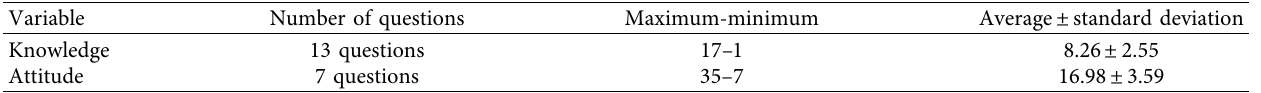
Table 2: Determine mean and standard deviation of knowledge and attitude in taxi drivers.